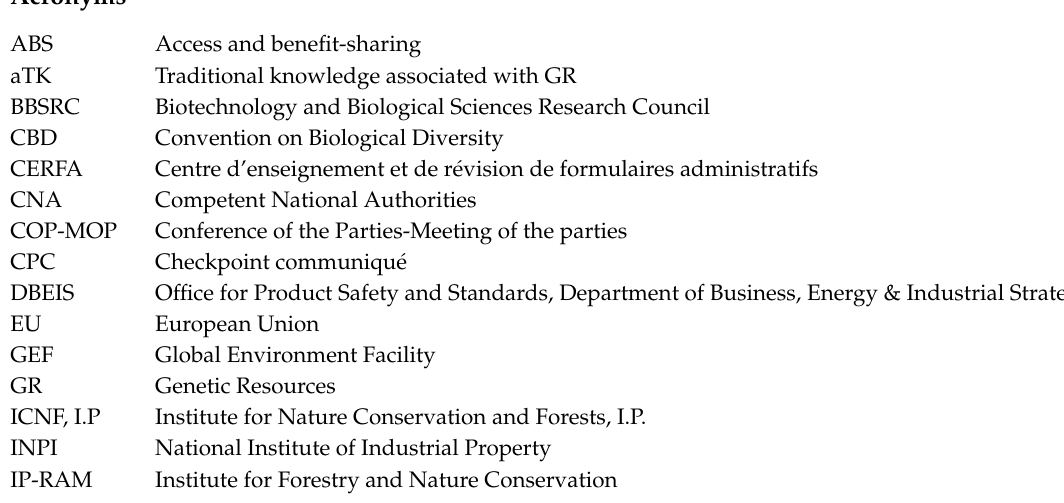
Table S1. List of relevant contacts in the aim of the Nagoya Protocol available at the ABS Clearing House